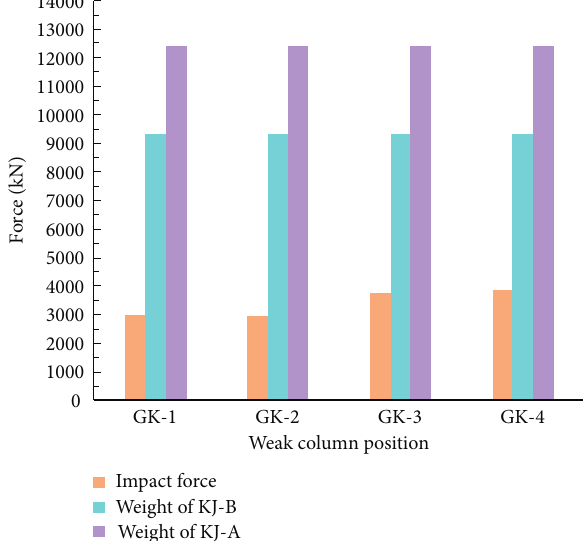
Figure 6: Maximum impact force corresponding to different weak column positions (PGA �